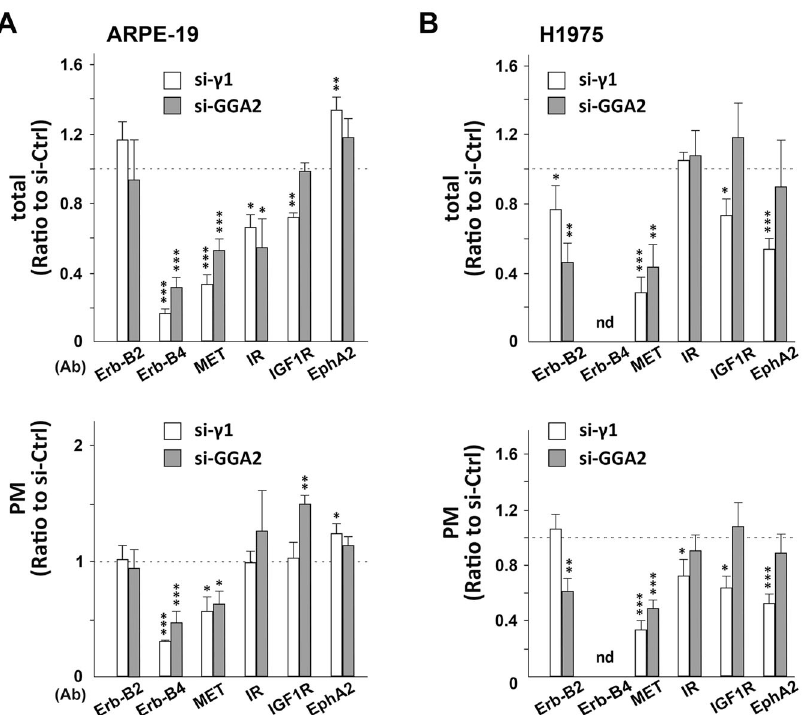
Fig. 7 Depletion of AP-1 or GGA2 causes downregulation of other RTK proteins. A , B Quantitative data of western blotting of ARPE-19 ( A ) and H1975 ( B ) cells transfected with siRNA for control (si-Ctrl), γ 1-adaptin (si- γ 1), or GGA2 (si-GGA2). See the blot images in Supplementary Fig. S6A. After biotinylation of surface proteins, lysates of the transfectants (total) and the PM fraction (PM) were analyzed using antibodies against RTKs (Erb-B2, Erb-B4, MET, IR, IGF1R, and EphA2). The ratio of si- γ 1 or si-GGA2 (corresponding to si-GGA2-#2 in Supplementary Fig. S6A) to si- Ctrl (indicated by the broken line) was plotted as the mean ± SD (of three and four experiments for ARPE-19 and H1975, respectively). Statistical differences between each siRNA and si-Ctrl were analyzed using Student ’ s t -test (* P < 0.05, ** P < 0.01, and *** P <